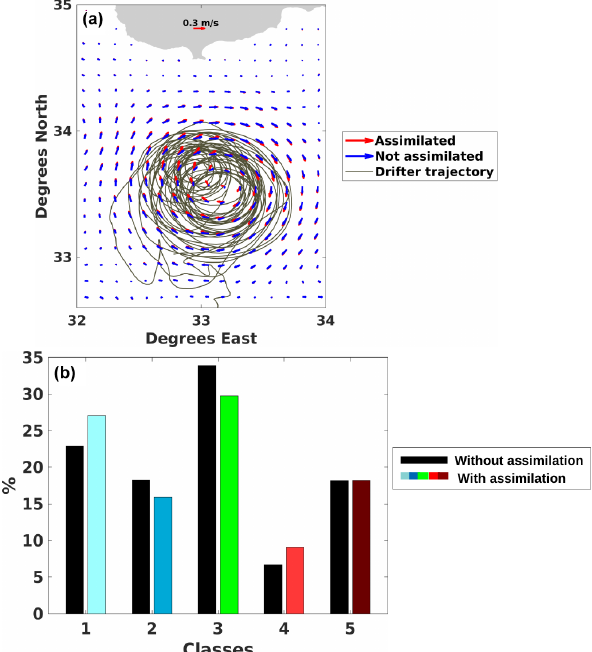
Figure 10. (a) The average velocity field obtained before (blue) and after assimilating (red) the drifters’ trajectories represented by the grey lines, circulating in CE from the start of March until late July. (b) The percentage of pixels assigned to the clusters from 1 to 5 before (dark bars) and after assimilation (colored